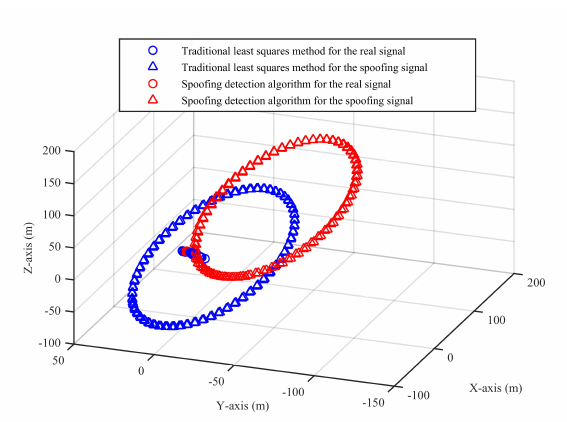
Figure 5. Three-dimensional results of the two algorithms (Experiment No. 2).